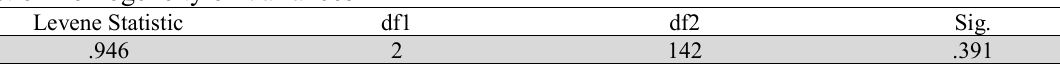
Test of Homogeneity of Variances